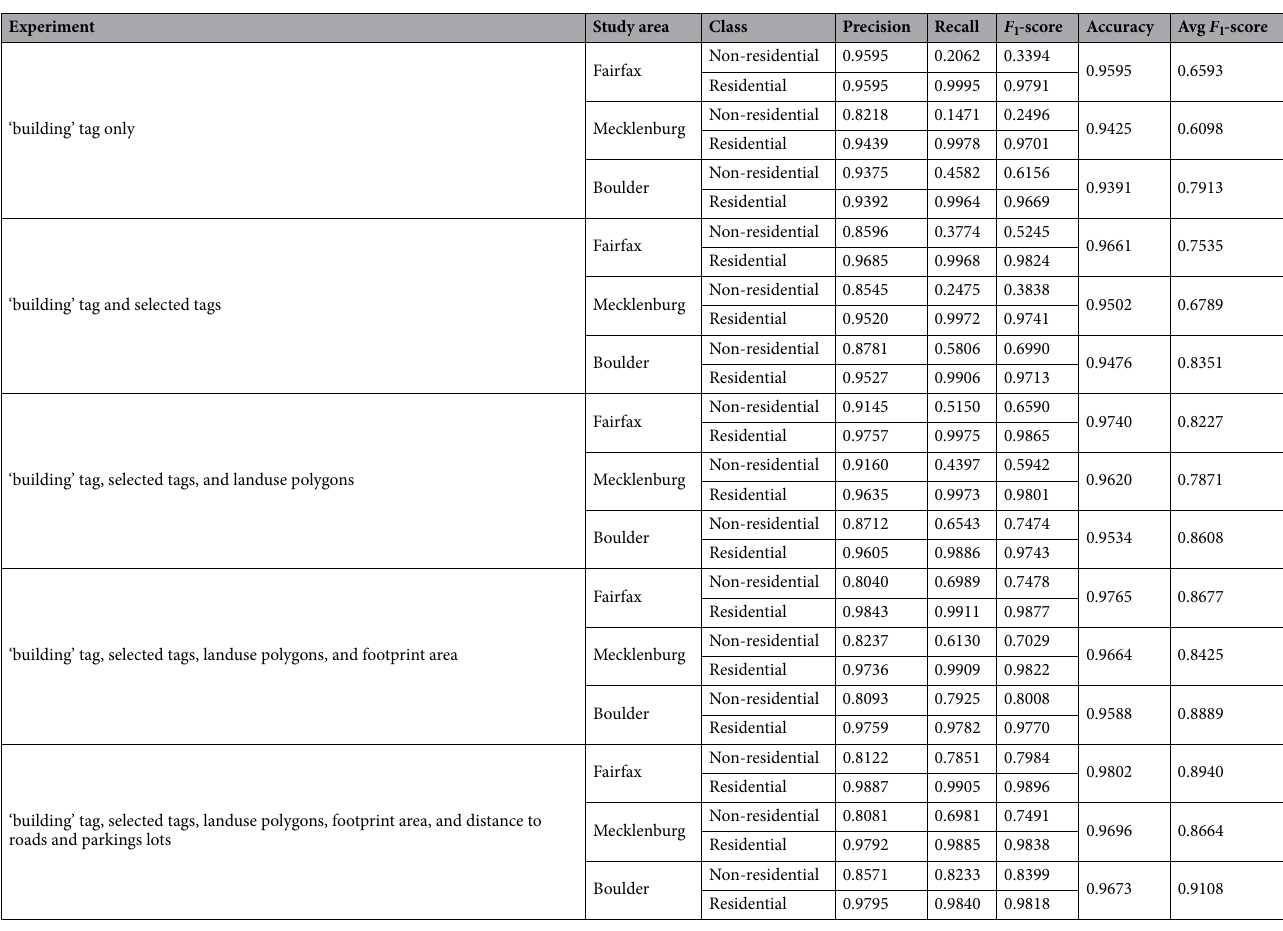
Table 7. Ablation study results.